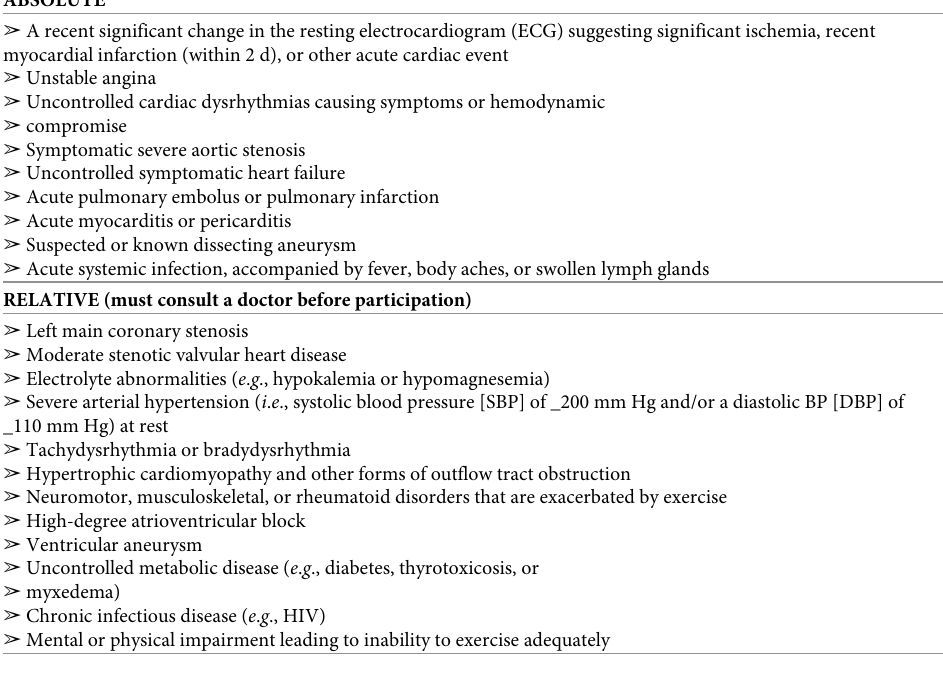
Table 1. Contraindications to exercise testing.